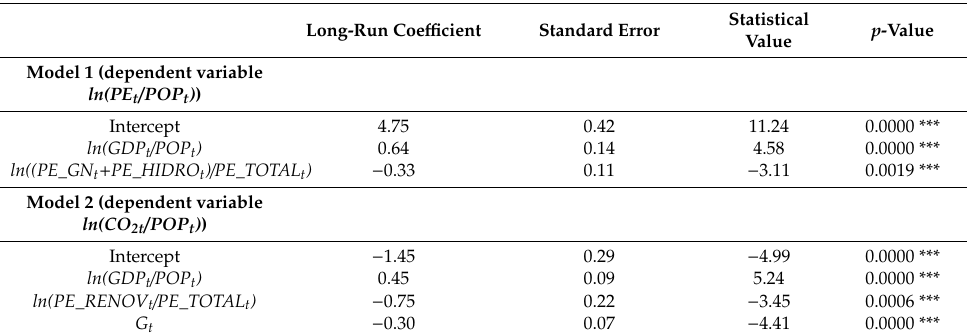
Table 3. Long-run estimates of the linear version of models 1 and